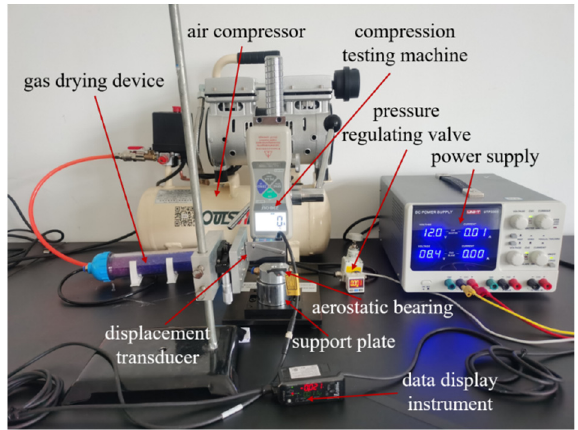
Figure 9. Experimental device for measuring static characteristics of aerostatic bearing.